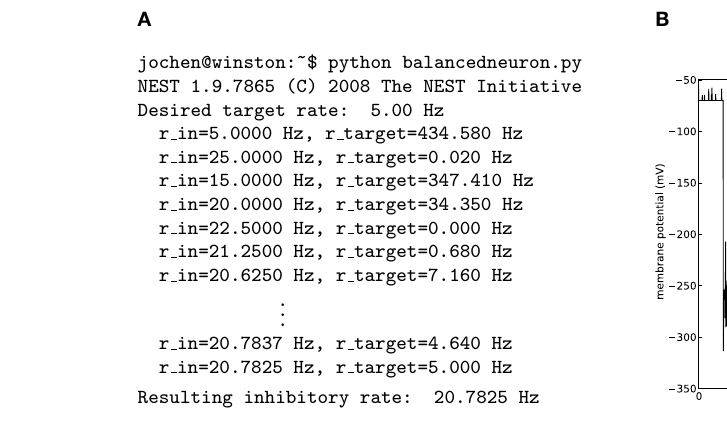
as a function of time. Repeated adjustment of the spike rate of the inhibitory population by bisect() results in a convergence of the mean membrane potential to − 112 mV, corresponding to an output spike rate of 5.0